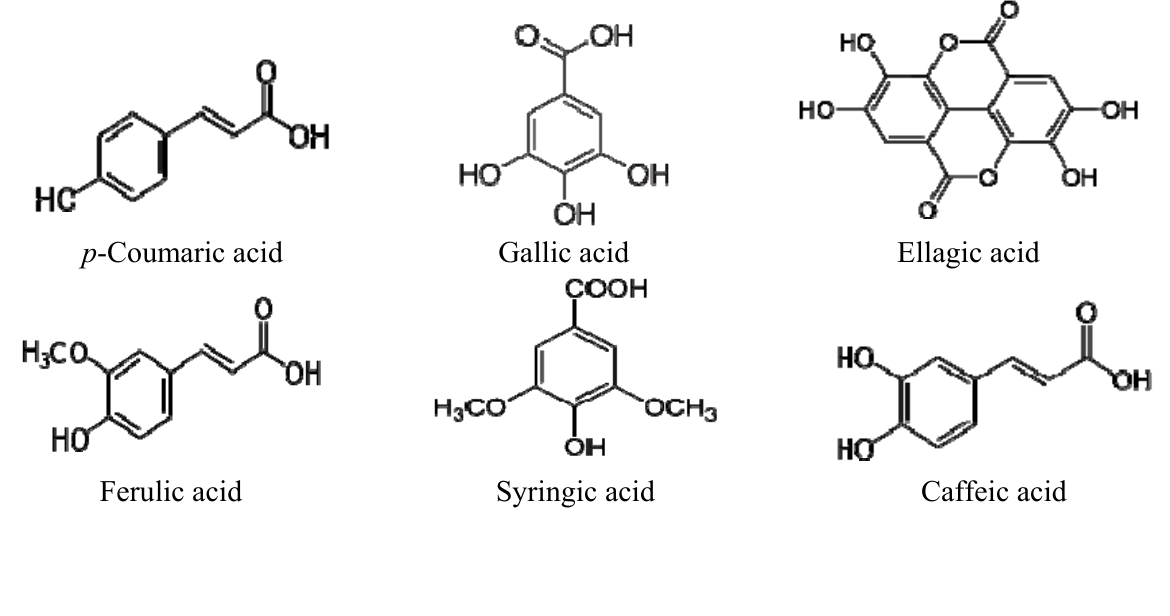
Figure 3. Chemical structures of phenolic acids in